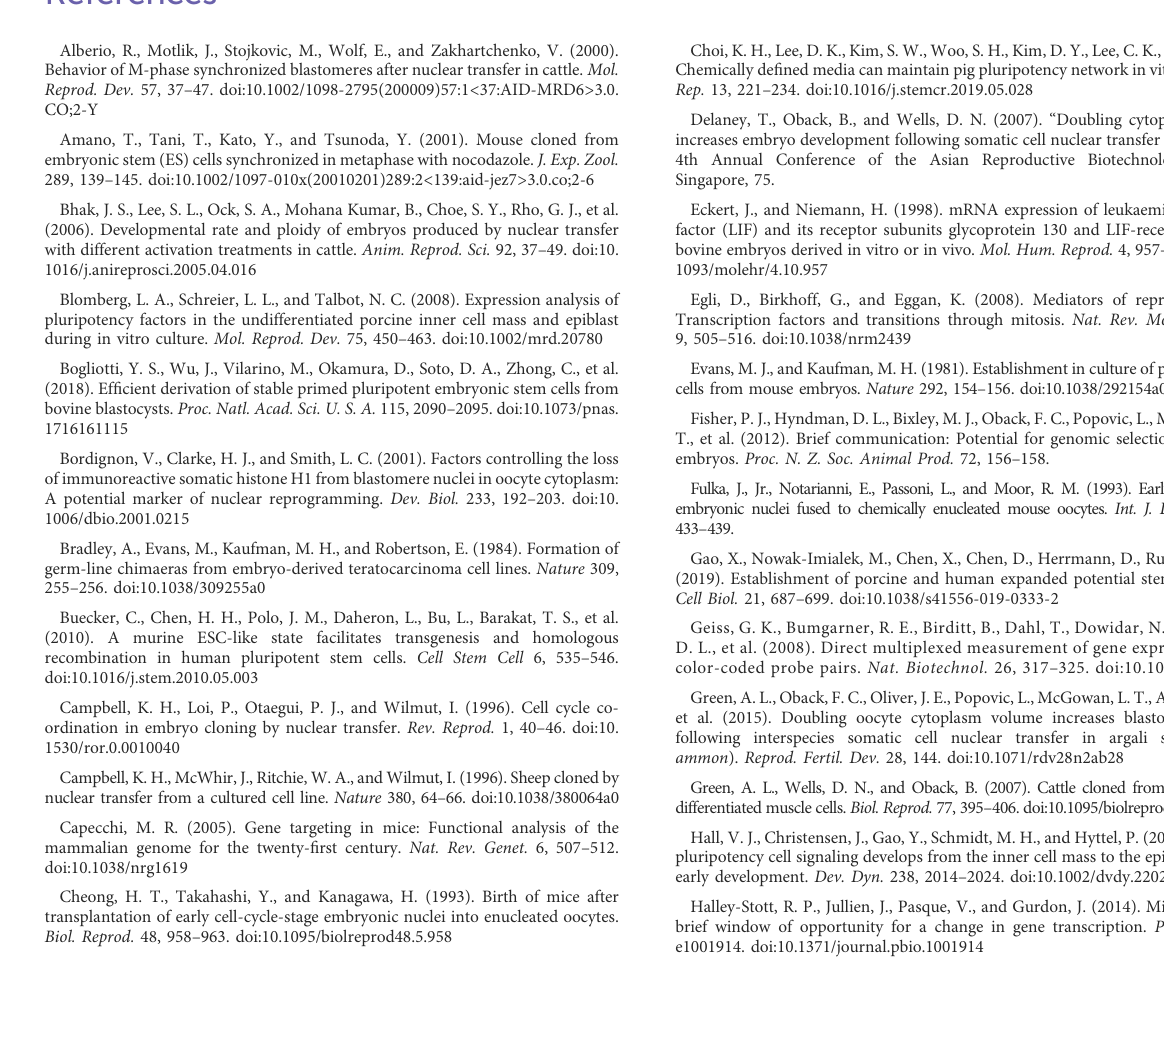
SUPPLEMENTARY FIGURE S4 Effect of CHIR99021 exposure on donor cell karyotype. Average proportion ofdiploidmetaphasespreads(± 10%)from (A) bovineembryonic fi broblasts (BEF) cultured in DMEM/F12-based growth medium for six days with or without CHIR99021 and (B) from ICM-derived colonies cultured in 2i+ or N2B27 base medium for 6 vs. 14 days with or without CHIR99021; N = number of metaphase spreads counted. SUPPLEMENTARY FIGURE S5 Predicted karyotype after mitotic ECT. Homologous chromosomes are shown in red and black. C = nuclear DNA content, N = nuclear chromosome number. Following arti fi cial activation with 6-DMAP, the ECT reconstructs do not extrude a pseudo polar body, potentially resulting in tetraploid (4N) blastocysts (top path). In the absence of 6-DMAP, the ECT reconstruct commonly extrudes all chromosome (bottom path). Extrusion of a diploid (2N) pseudo-polar body was not observed (middle